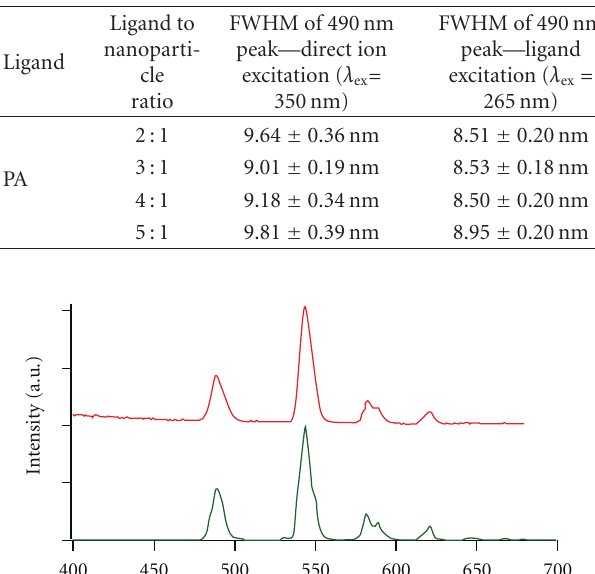
Table 4: FWHM values for PMMA nanocomposites composed of varying ratios of PA:Tb 3+ :LaF 3 .